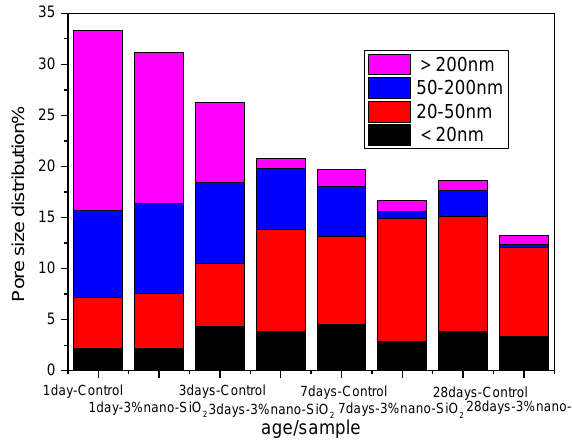
Figure 13. The pore size distribution and porosity of set cement paste with different